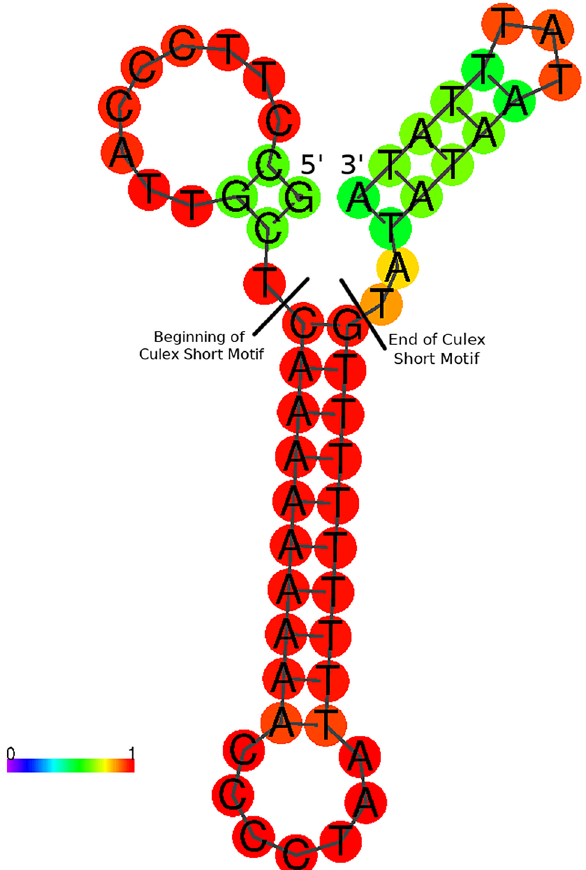
Figure 5. Predicted secondary structure of NC_014574 ( Culex quinquefasciatus ) Culex Short motif and surrounding bases at 25 °C. Coloured scale represents the probability of bases being in the state represented. Bases are coloured according to the likelihood they are in their shown state. Blue/purple bases are unlikely, cyan/ green are somewhat likely, and yellow/red are the most likely. Predictions made with ViennaRNA v 2.4.14 using DNA stacking